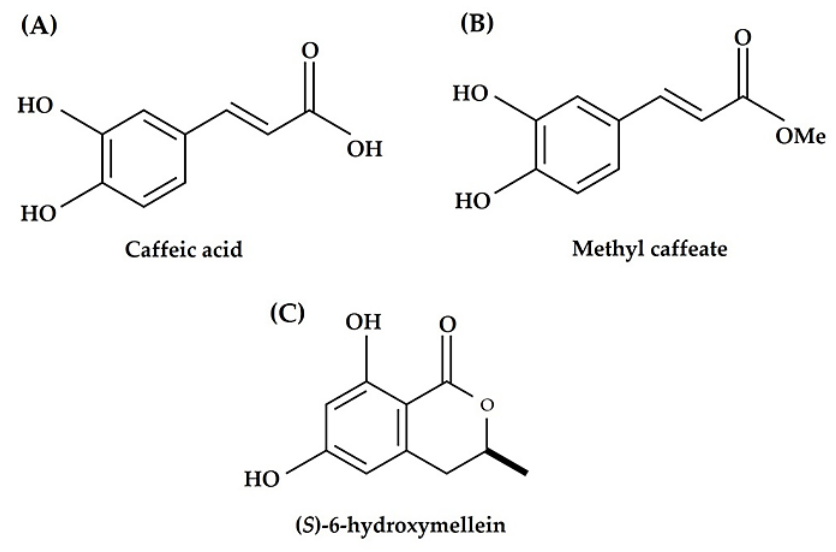
Figure 3. Chemical structures of the compounds isolated from the S. garrettiana leaf extracts: (A) caffeic acid, (B) methyl caffeate, and (C) ( S )-6-hydroxymellein.